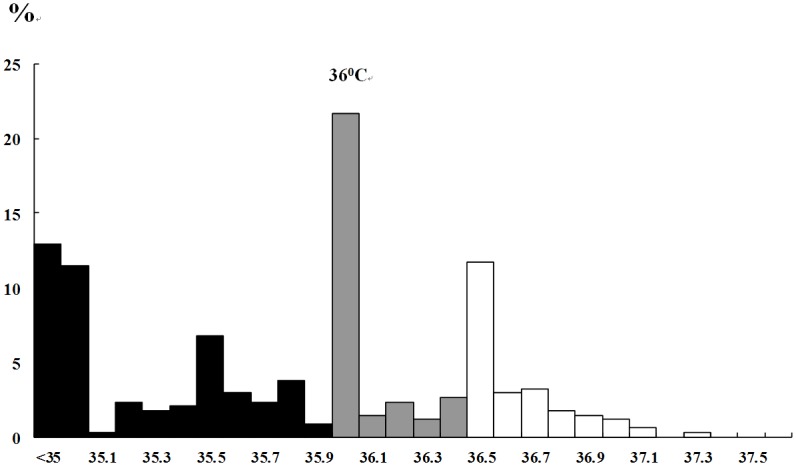
Temperature at admission to NICU (degrees centigrade).